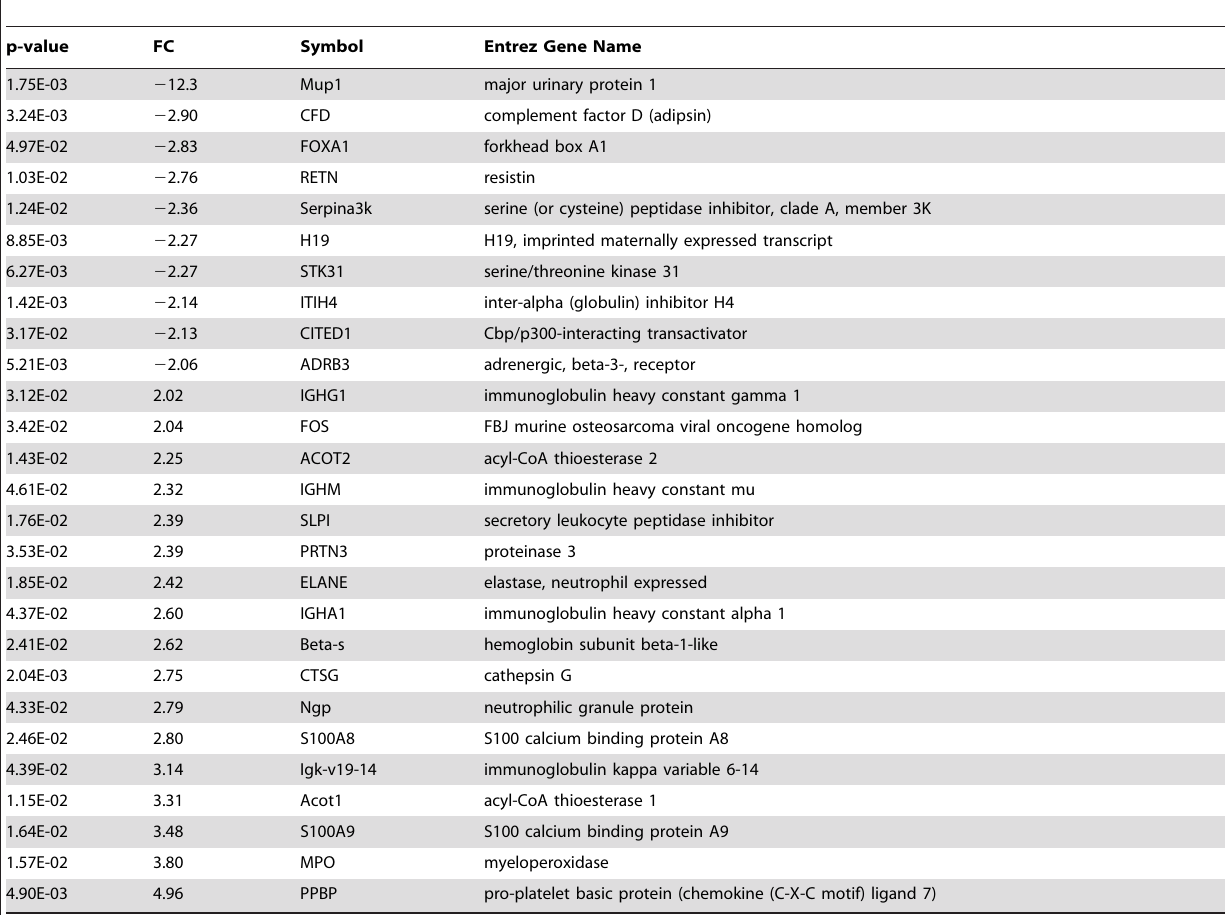
Table 3. Genes differentially expressed in WT vs. H 3 RKO LN after CFA + PTX treatment.